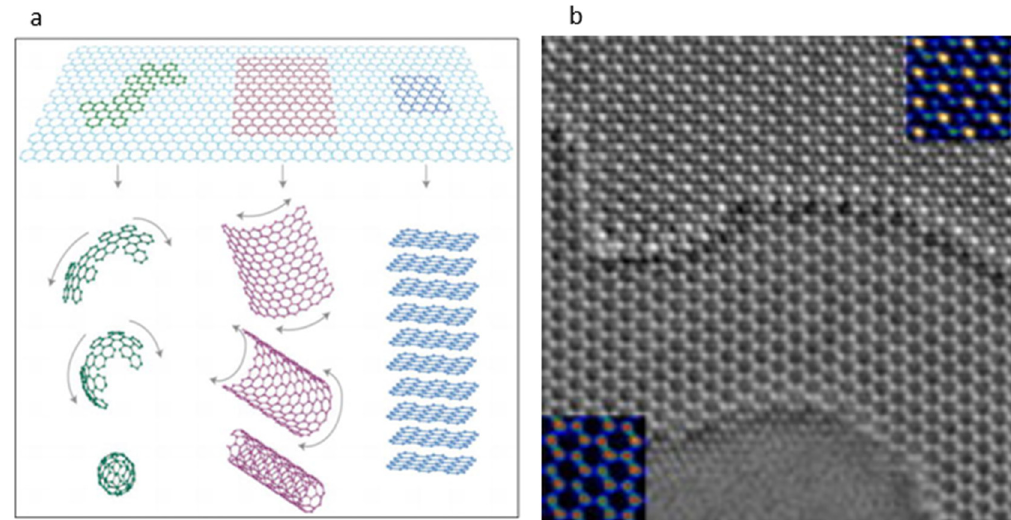
Figure 4. ( a ) Two-dimensional graphene sheets in various shapes: green shows 1D fullerene shapes, red shows graphene rolled into nanotubes, blue shows graphene stacked into 3D graphite [67] Reprinted with permission from Ref. [67]. Copyright 2007 Nature Publishing Group.; ( b ) atomic arrangement of single- and double-layered graphene [68]. Reprinted with permission from Ref. [68]. Copyright 2010 Elsevier Ltd.